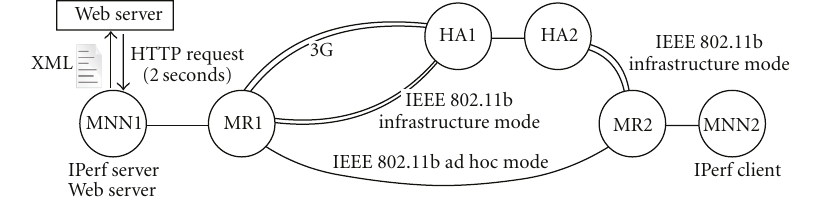
Figure 8: Network topology of the MANEMO demonstration system.